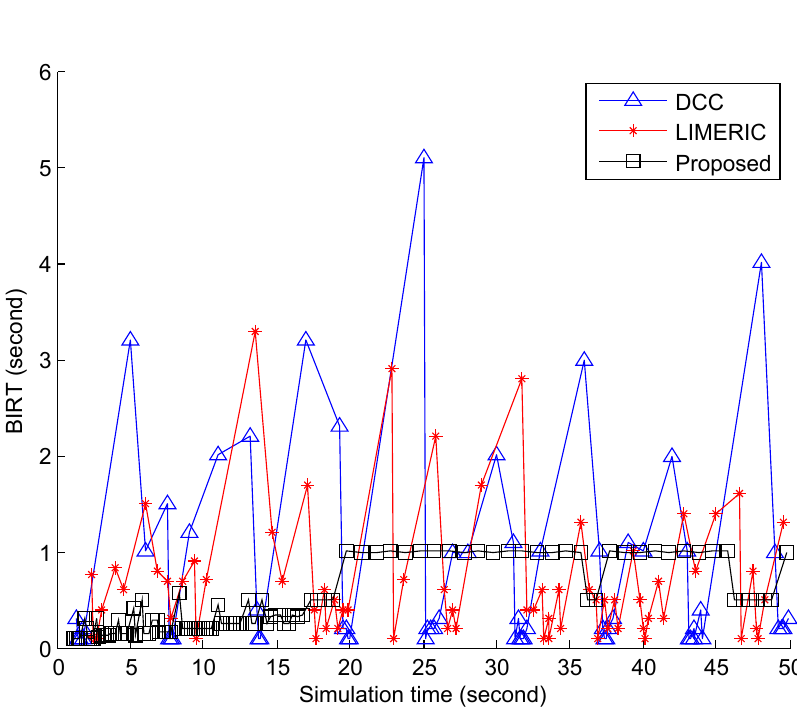
Figure 3. BIRT of a vehicle 50 m away from the reference vehicle.